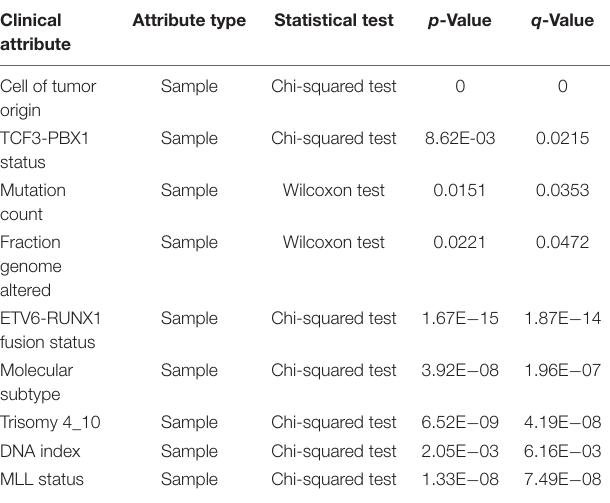
TABLE 4 | Comparison of Molecular attributes of ADAM6 homozygous deletion (ADAM6:HOMDEL) versus ADAM6 wild-type (WT:ADAM6)